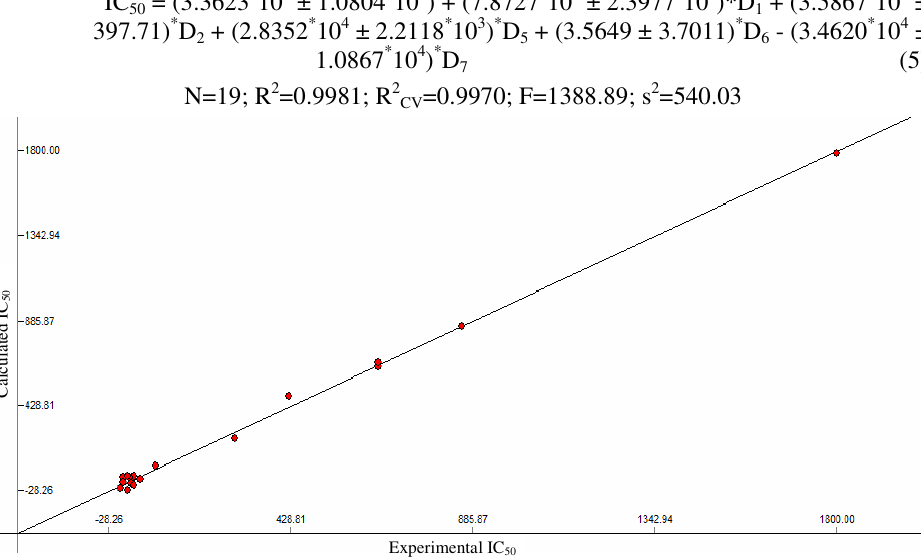
Figure 1. Comparison of experimental and calculated biological activity from the regressional analysis in eq. (4). R 2 = 0.9967; R 2